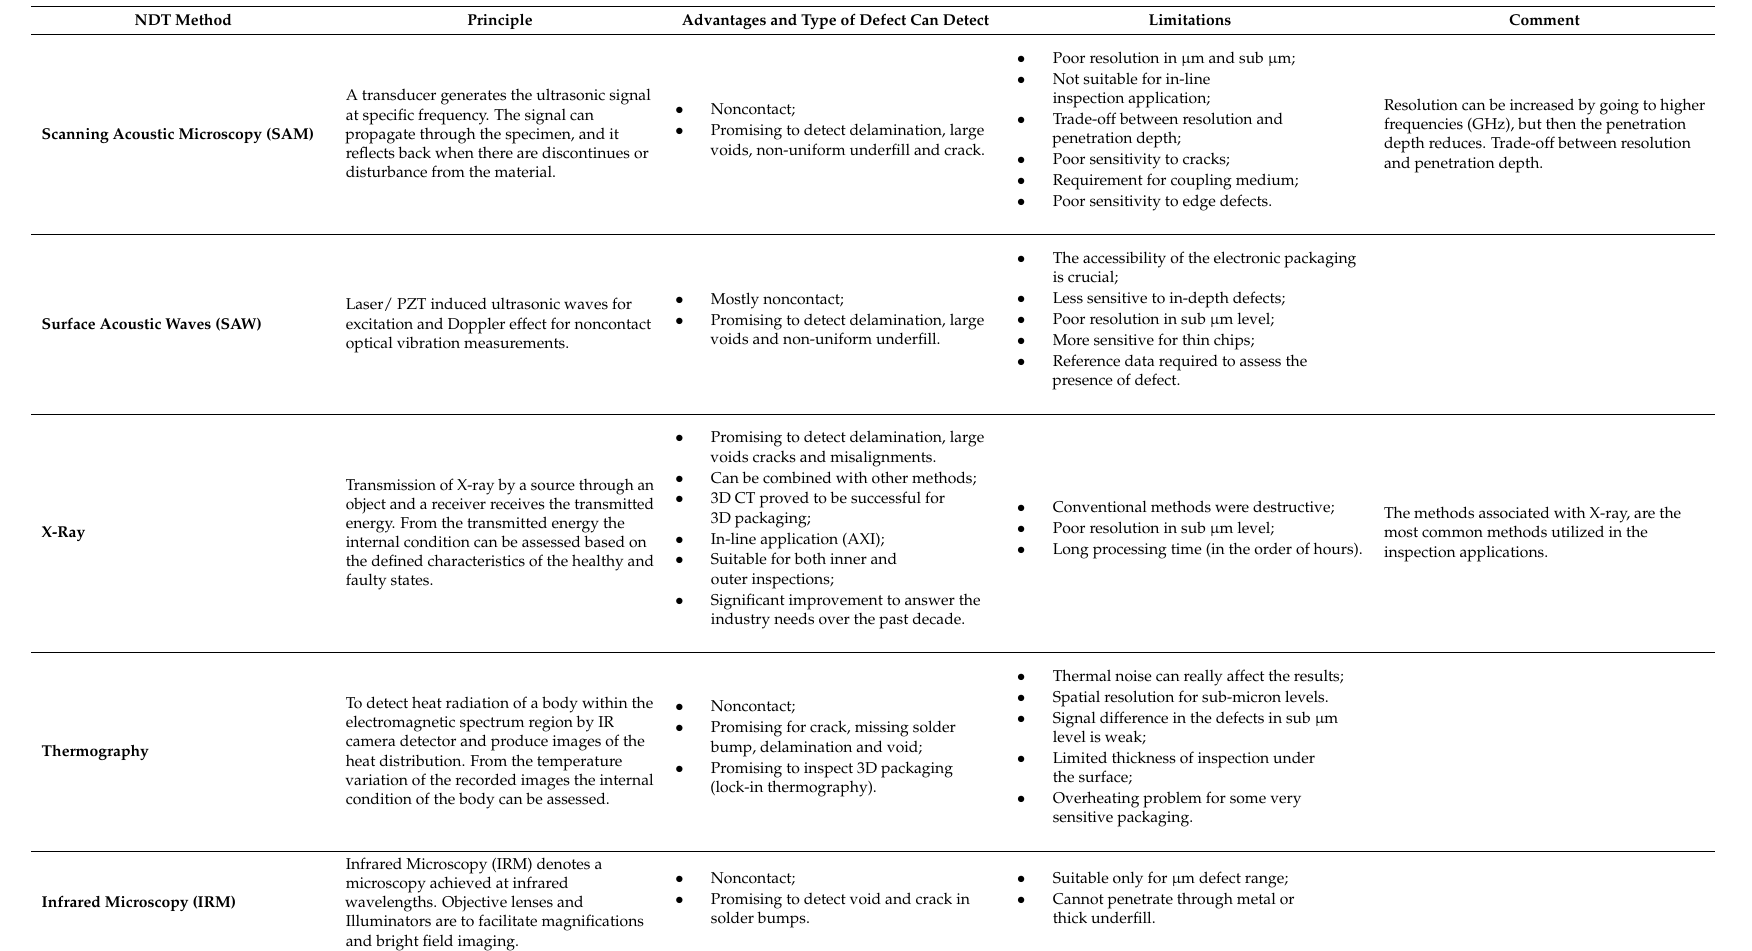
Table 1. Summary of the NDT methods for IC